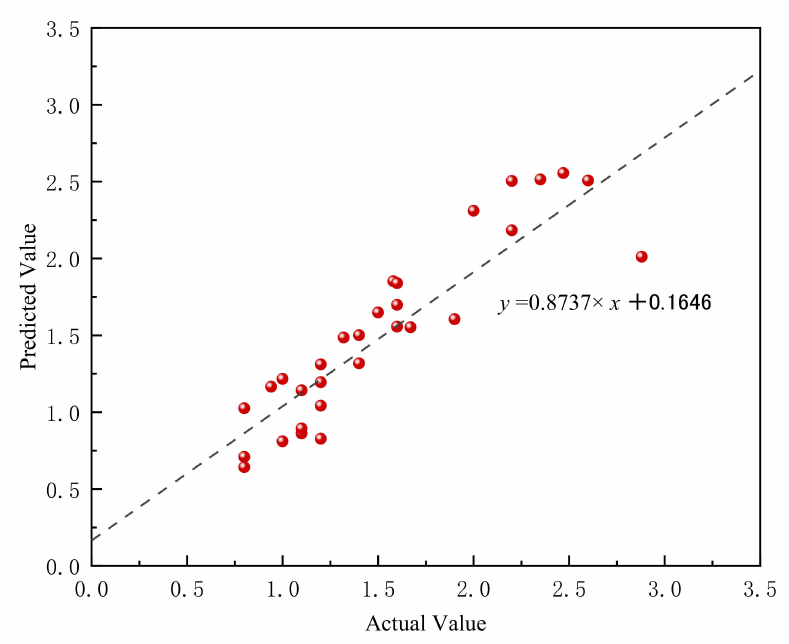
Figure 15. Predictive performance of SSA-SVR